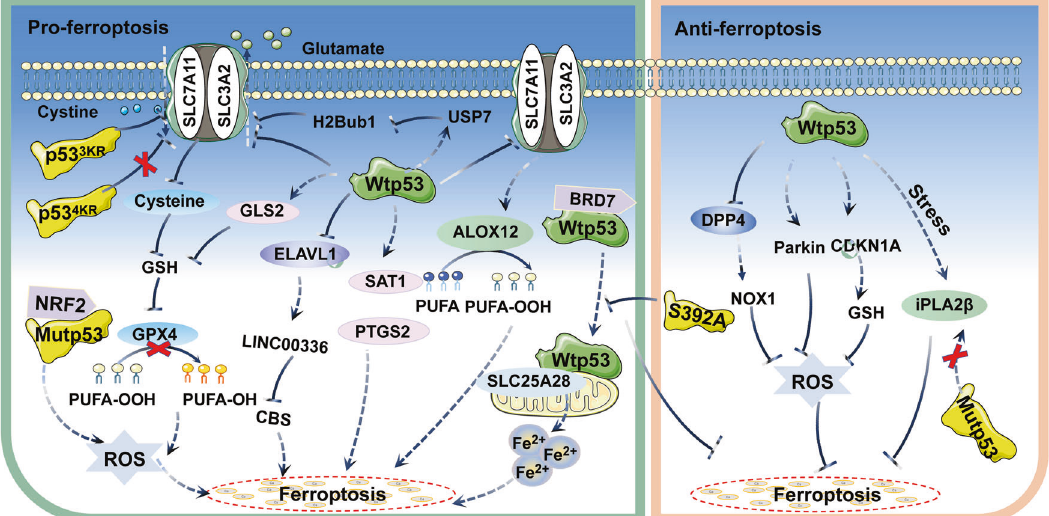
Fig. 4 Schematic representation of the mechanism of mutp53 in ferroptosis. p53 can regulate the ferroptosis pathway through diverse mechanisms. In most cases, p53 promotes ferroptosis. However, in certain circumstances, p53 can inhibit the onset of ferroptosis.